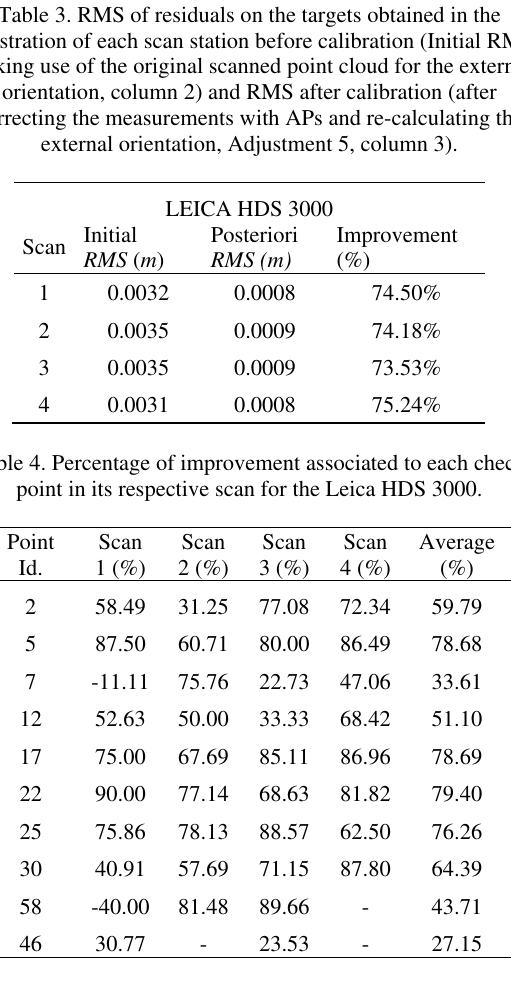
Table 5. Geometric calibration quality estimators obtained for the FARO LS 880 with distinct parameterization: 1) All APs; 2)